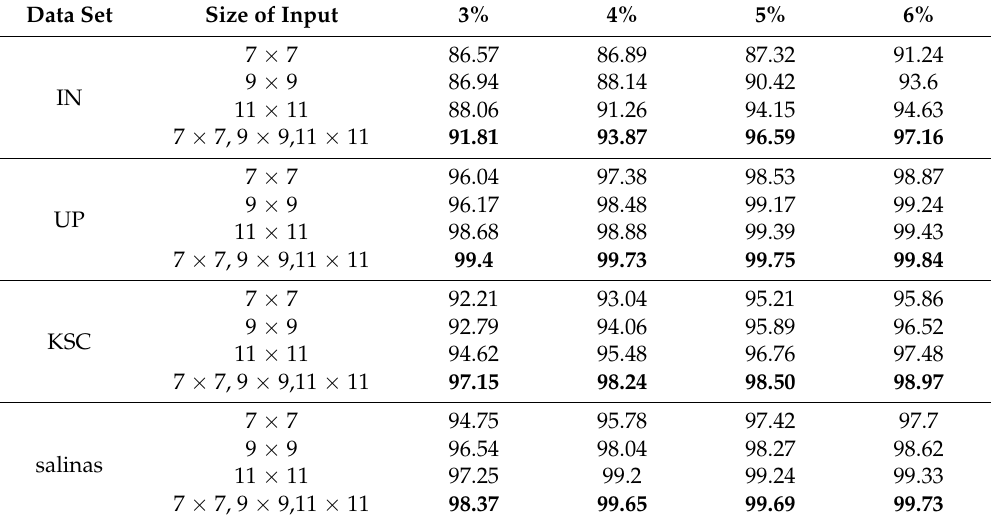
Table 6. Classification results (OA%) of our methods on the four data sets with different input sizes when the percentage of training samples is